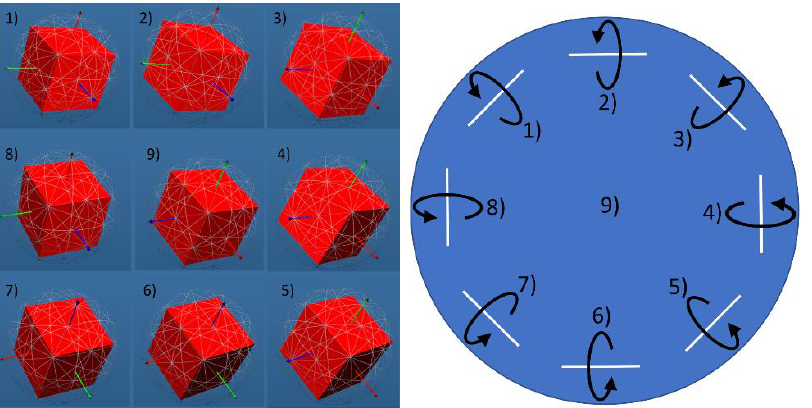
Figure 8. Schematic view of orientation rotation. Circle here represents a spherulite. Orientation in the center of it (point 9) is [111]. This orientation is shown on left panel. To the sides (1,2,3…) it rotates around the axes that are shown as white lines. Glassceram substrate.